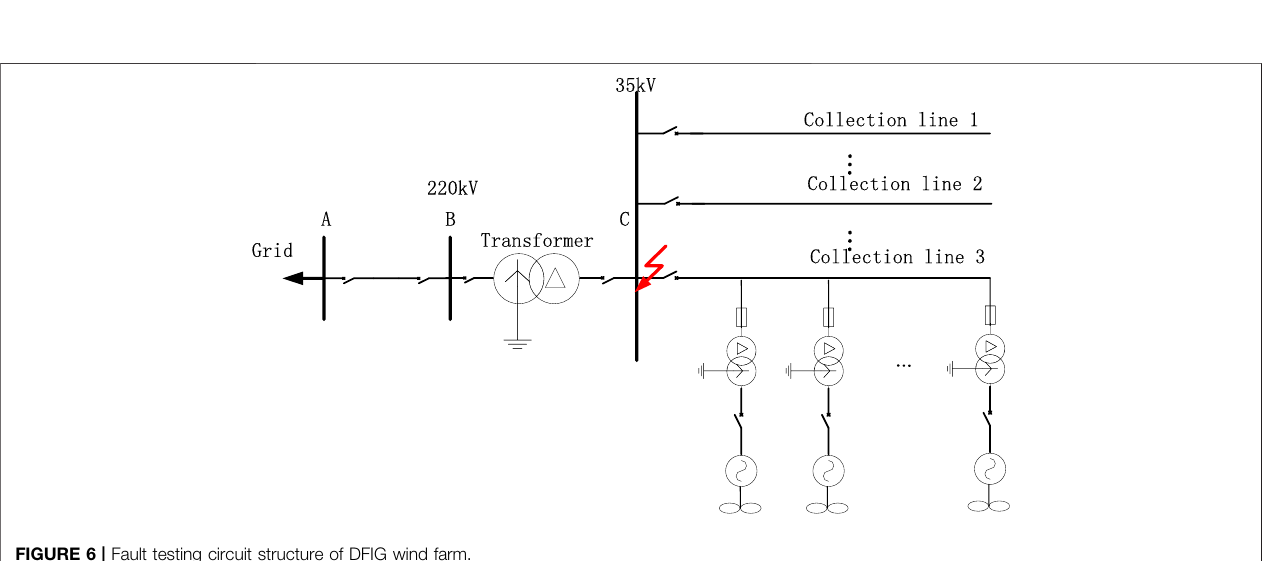
FIGURE 6 | Fault testing circuit structure of DFIG wind farm.